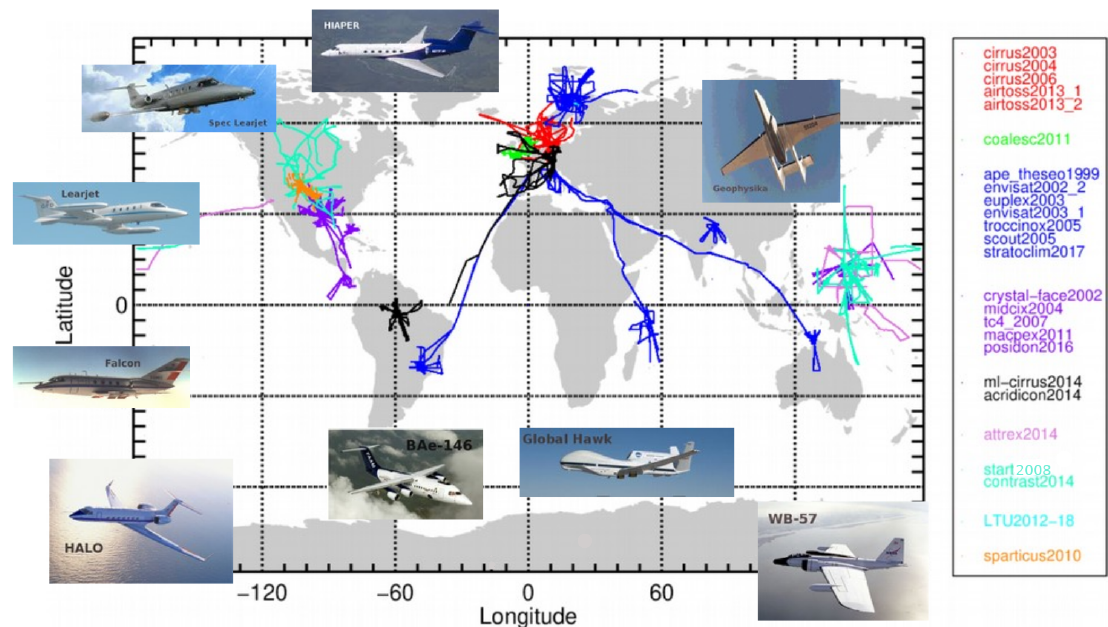
Figure 1. Aircraft flight paths during the 24 campaigns listed in Table A2. A total of 185 flights, 192h IWC measurements, 90h N ice , 84h R ice , 116 and 331h RH ice in- and outside cirrus (campaign names: red – GfD Learjet, green – BAe 146, blue – Geophysica, purple – WB-57, black – HALO, light purple – Global Hawk, cyan – GV HIAPER, orange – Spec Learjet). In comparison: Schiller et al. (2008) and Krämer et al. (2009) – 52 flights, 27h IWC measurements, 8.5h N ice , 8.5h R ice , 10 and 16h RH ice in- and outside